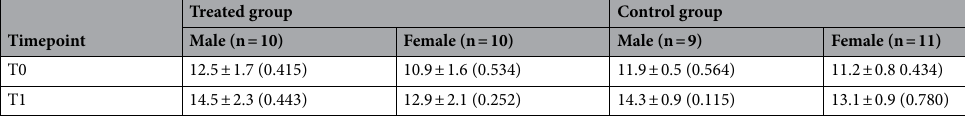
Table 1. Demographic characteristics of the skeletal class II treated and untreated groups. Mean ± standard deviation (p value from Shapiro–Wilk normality test). Age expressed in years.